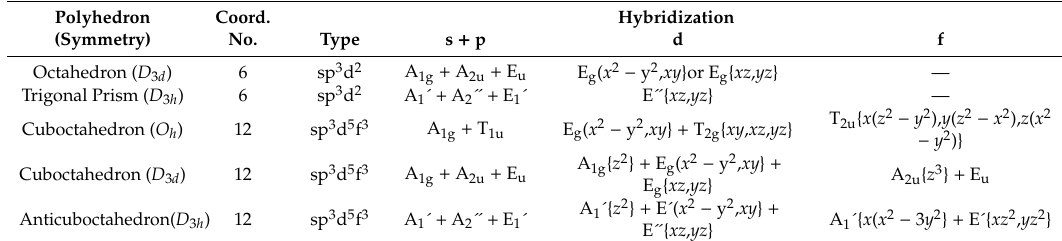
Table 6. Hybridization schemes for polyhedra with O h symmetry and the D 3 h polyhedral forme from them by a triple diamond-square-diamond